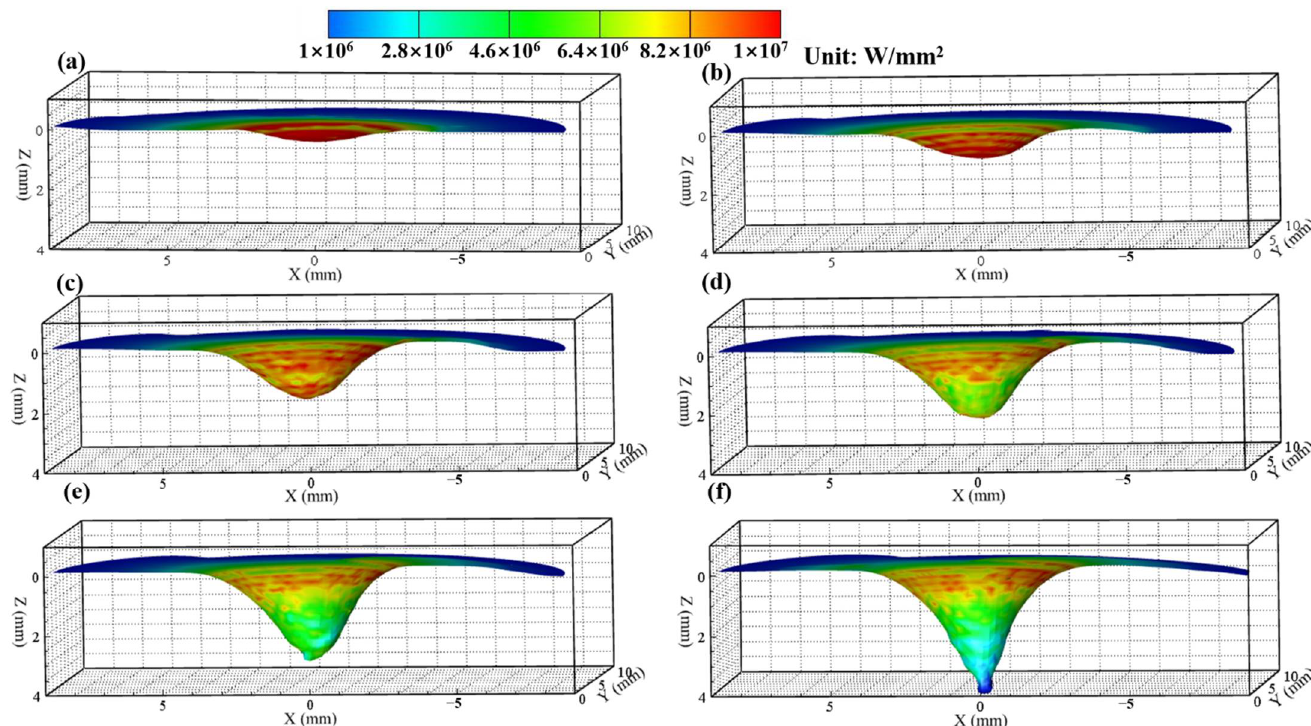
Figure 8. The dynamic keyhole evolution process in U-PAW ( a ) 1, ( b ) 2.01, ( c ) 2.6, ( d ) 3, ( e ) 3.31, ( f ) 4.2 s.